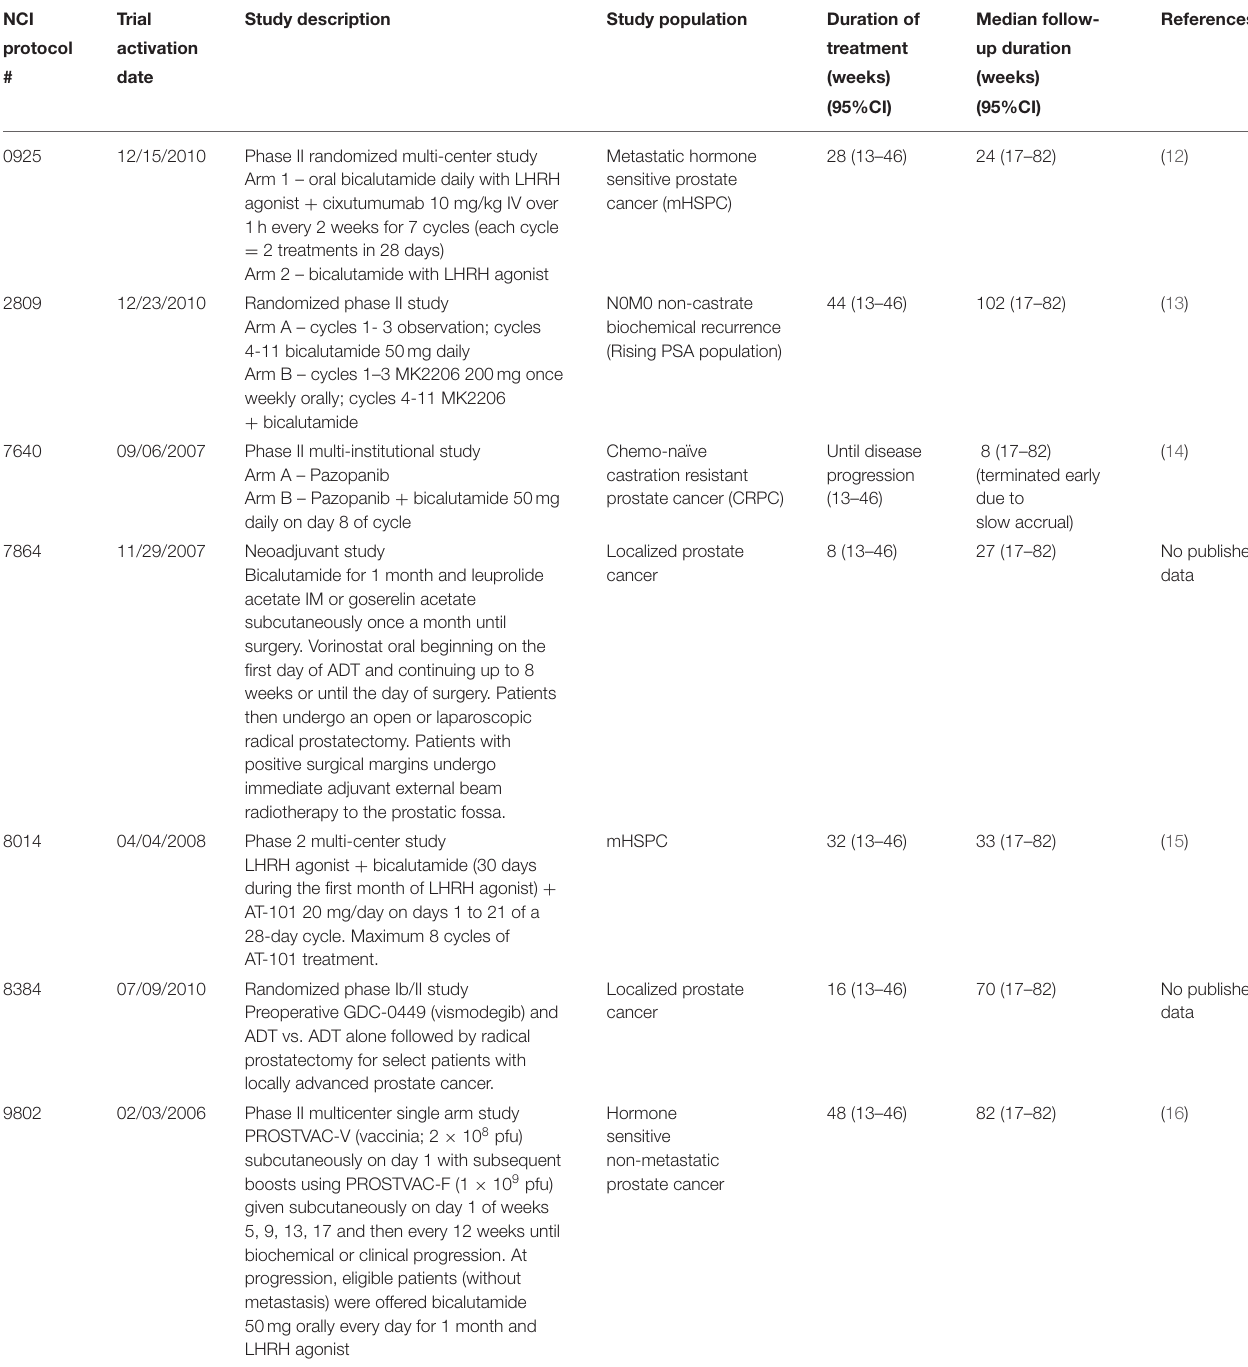
TABLE 1 | Description of the 7 NCI early phase trials included in this